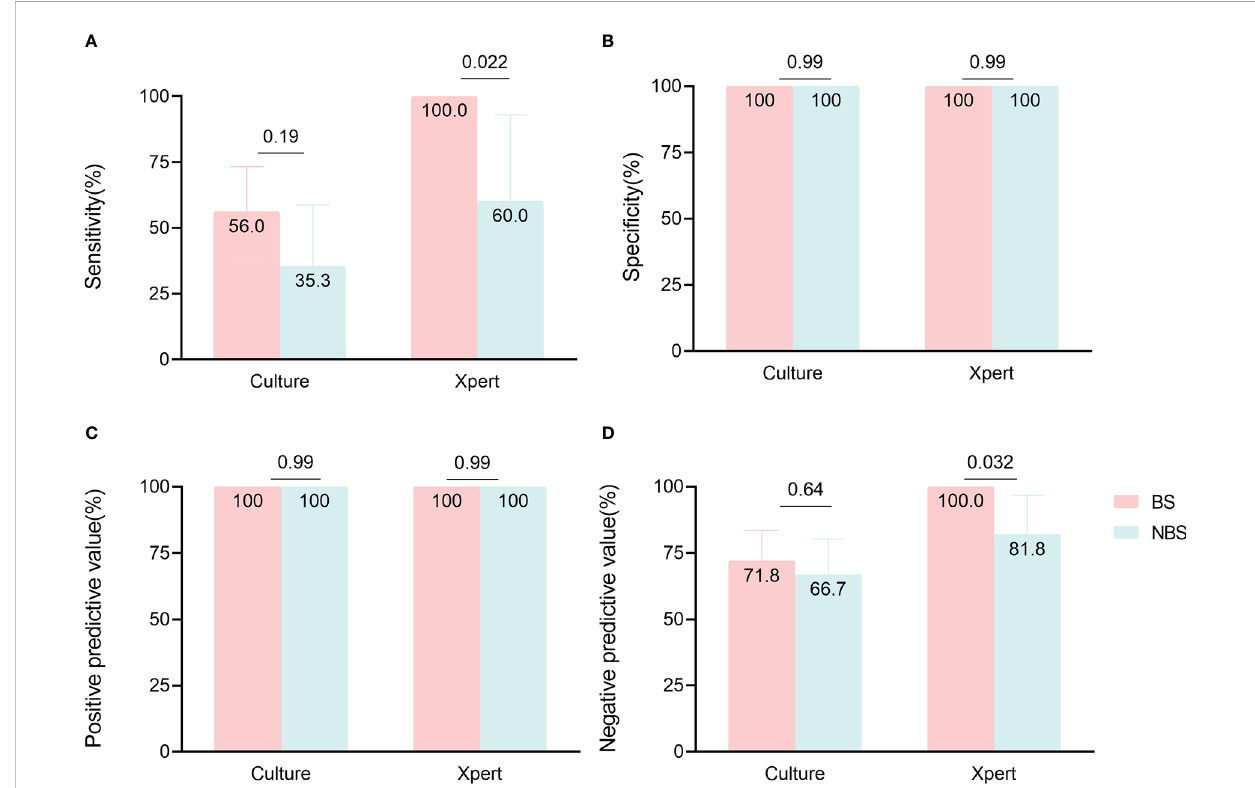
FIGURE 4 Comparison of culture and Xpert accuracy in paired biopsy samples (BS) and non-biopsy samples (NBS). Data are shown strati fi ed according to (A) sensitivity, (B) speci fi city, (C) positive predictive value, (D) negative predictive value.